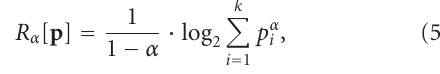
Figure 5: Stop codons in both strands of DNA.